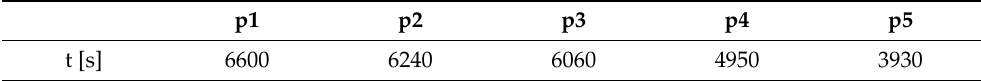
Table 9. Times at which the greatest differences in temperature values along the cylinder length occurred.